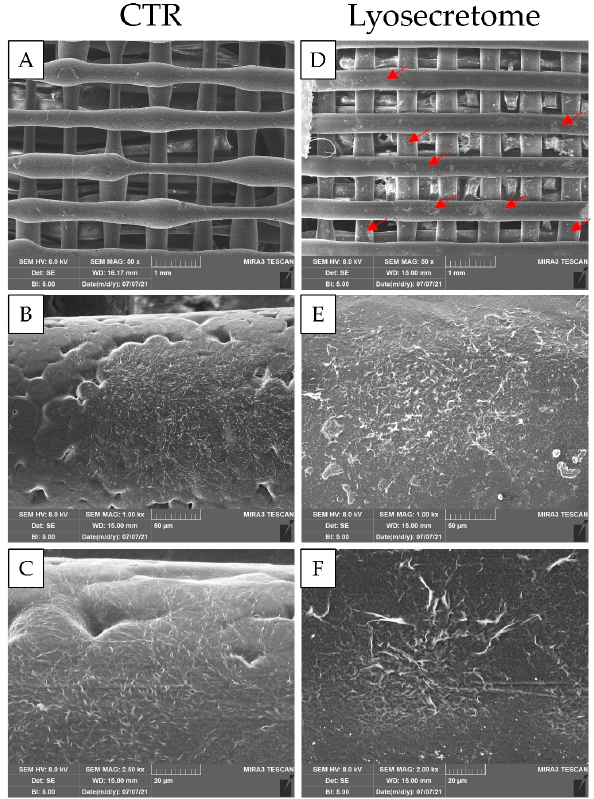
Figure 2. SEM morphological and structural characterizations of Lyosecretome and CTR scaffolds seeded with MSCs and cultured in osteogenic medium for 24 h. Magnifications: 50× ( A , D ), 100× ( B , E ), 2500× ( C ), and 2000× ( F ). The red arrows indicate the cells that colonized the PCL fibers. Scale bars: 1000 ( A , D ), 50 ( B , E ), and 20 ( F ) µm.